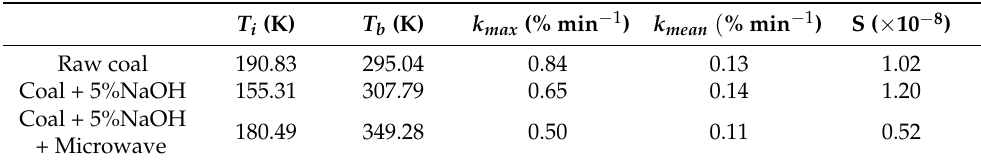
Table 3. S value of coal samples treated under different conditions.